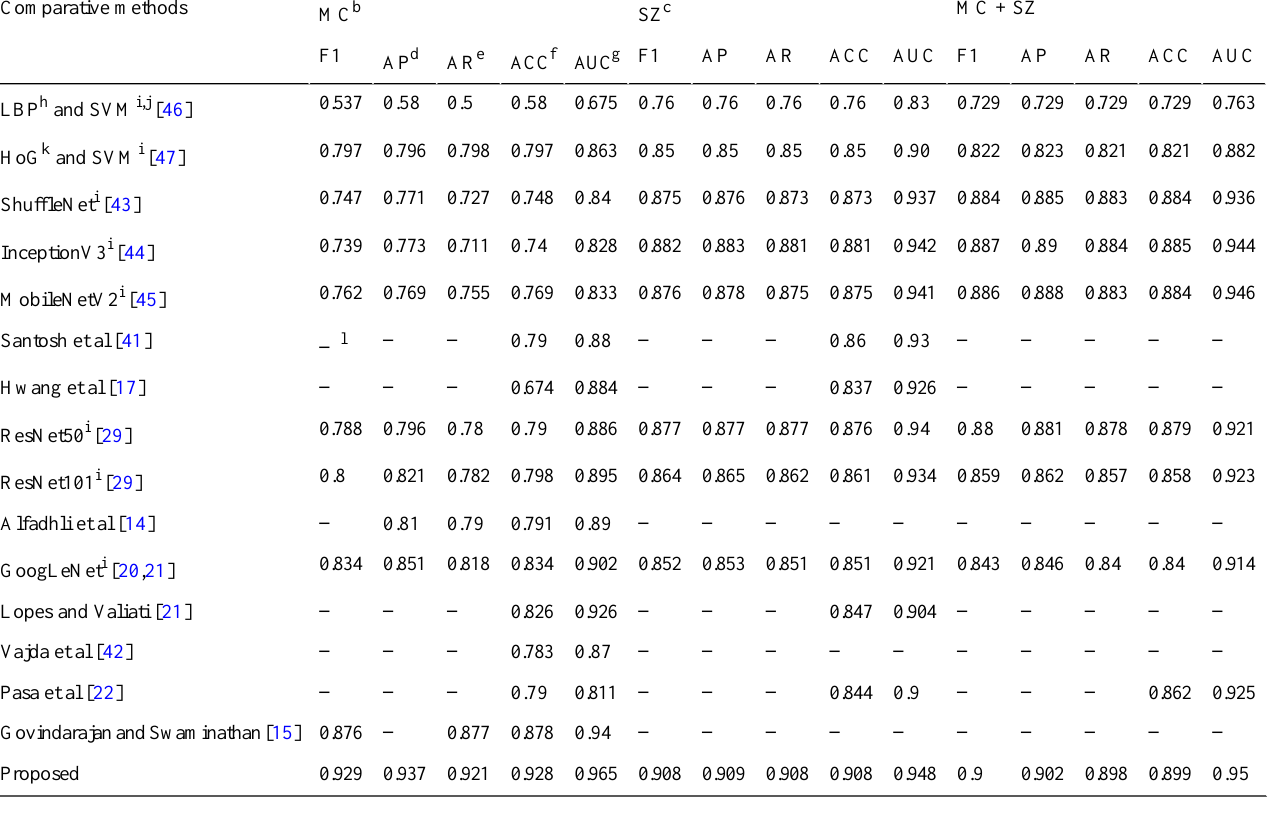
Table 5. Comparative performance analysis of the proposed ensemble-SDCNN a model with various state-of-the-art